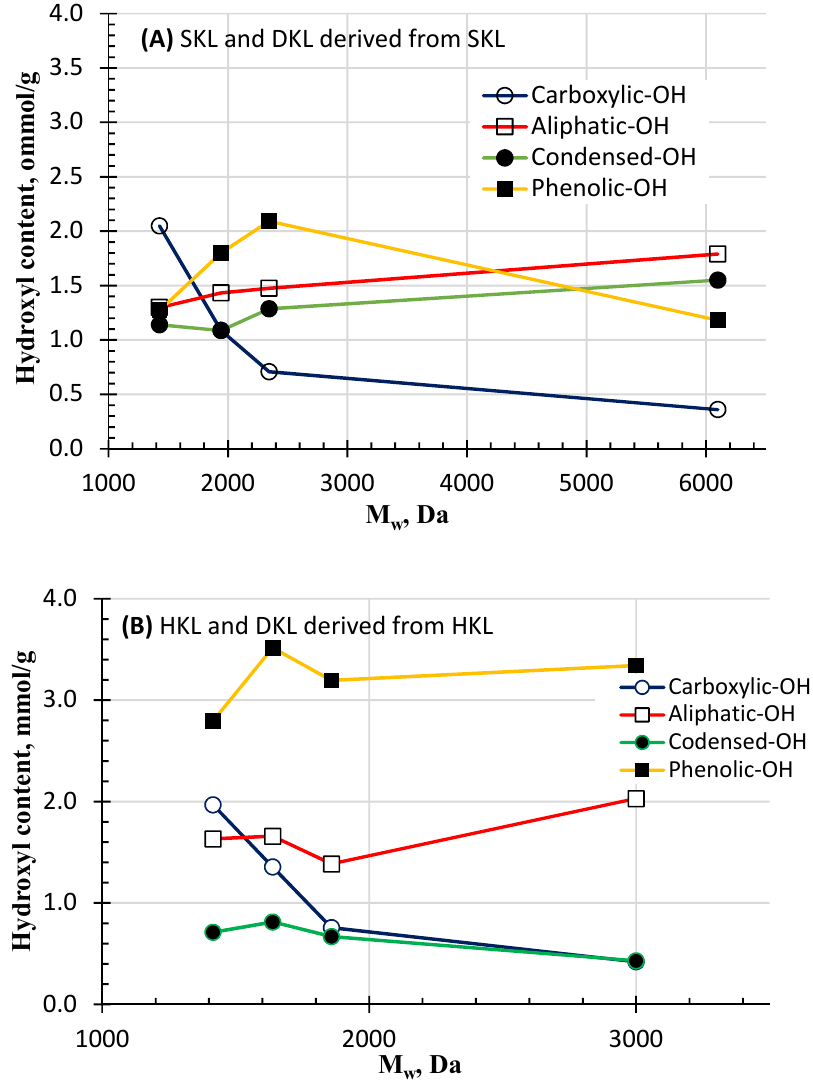
Figure 5. Contents of different hydroxyl functional groups vs. M w for SKL and DKL derived from SKL ( A ) and HKL and DKL derived from HKL ( B ).